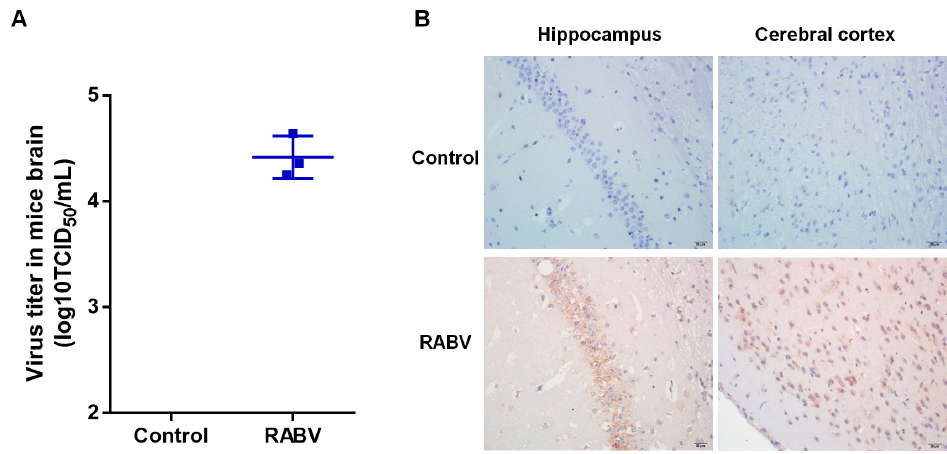
Figure 1. Establishment of RABV mouse infection model. ( A ) Quantification of infectious virus titer in mice brain by indirect immunofluorescence assay (IFA); ( B ) Immunohistochemistry (IHC) analysis of the cerebral cortex and hippocampus to visualize RABV infection using anti-N antibody. Scale bar = 20 µm.